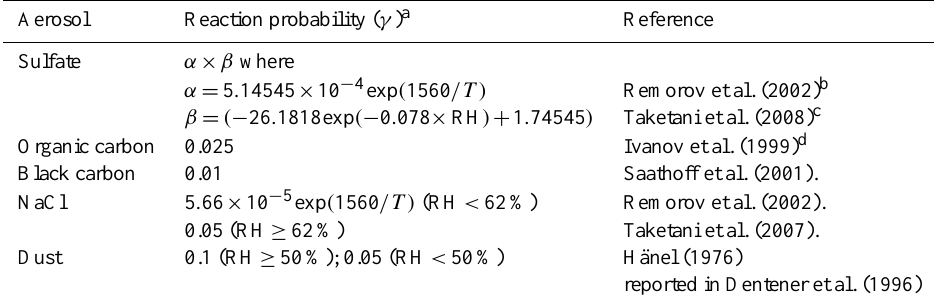
Table 1. Uptake coefficients for HO 2 . Aerosol Reaction probability ( γ ) a Reference